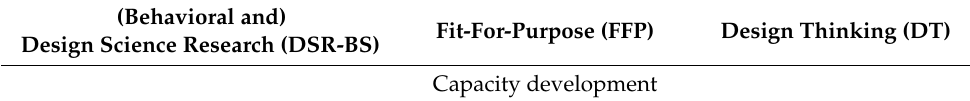
Table 8. Extract of the capacity development process